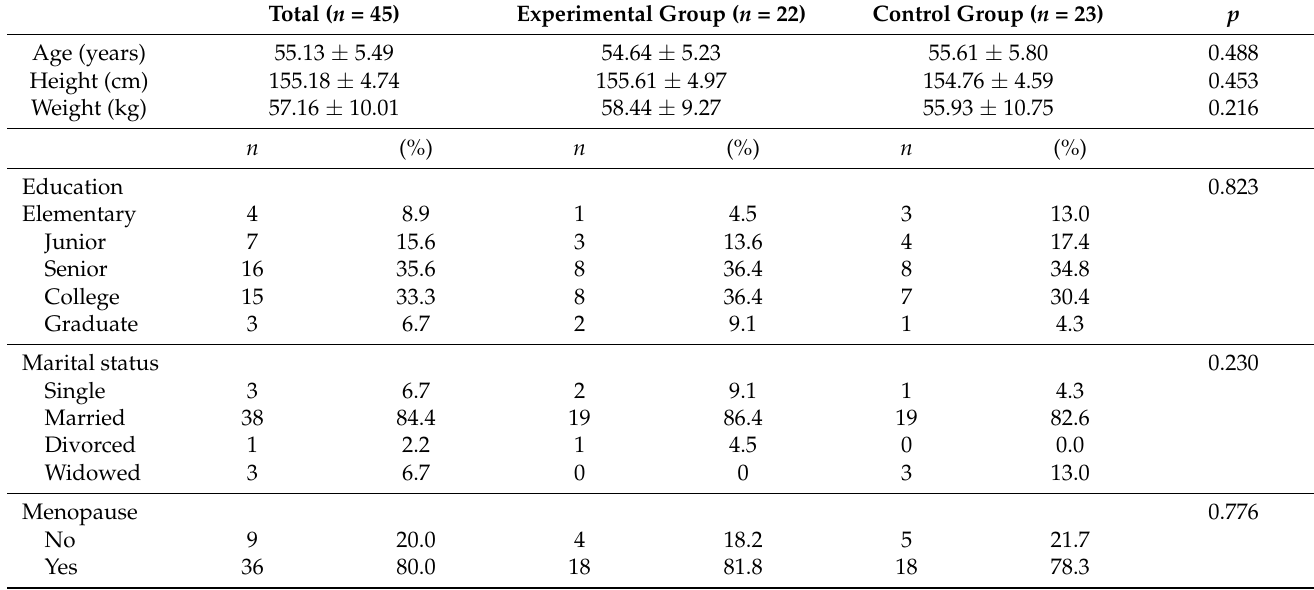
Table 1. Participant demographic